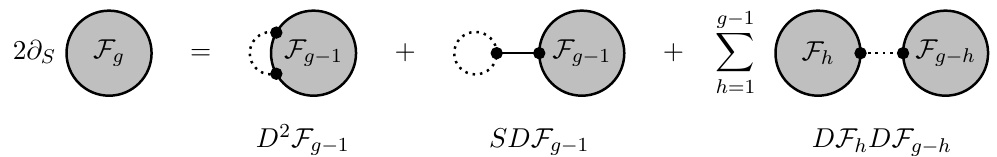
Figure 4 . Diagrammatic interpretation of the holomorphic anomaly equation (3.5). The propaga- tor removed by the action of ∂ S is indicated by the dotted